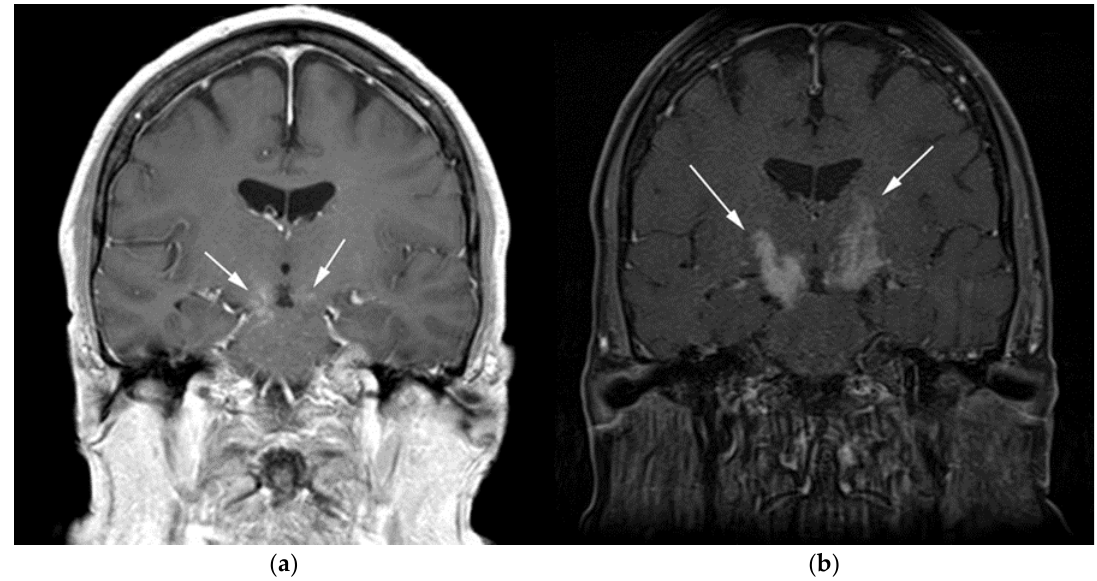
Figure 2. A 64-year-old-woman presenting with rapid onset of memory deterioration and altered sensorium. ( a ) Coronal MRI T1 post-contrast images show subtle enhancement along bilateral deep nuclei. At this time, no diagnosis was determined. After 3 weeks, patient presented to emergency department with worsening symptoms. A follow-up MRI was performed. ( b ) Coronal MRI post-contrast fat-saturated images revealed progressive increase in extent of diffuse infiltrative enhancing masses (white